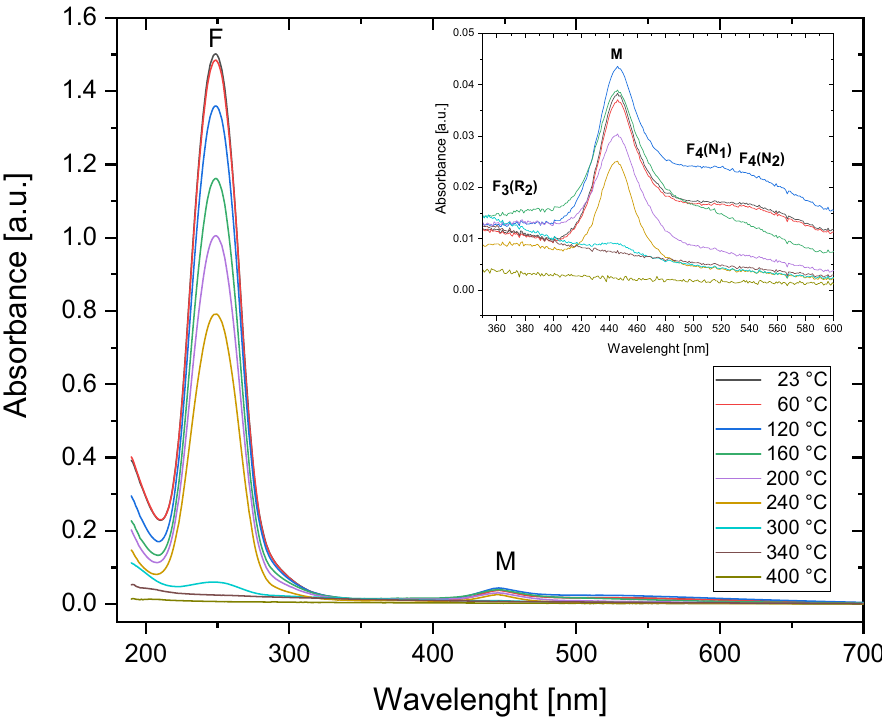
Figure 2. Absorption spectra for the sample irradiated with 30 kGy of beta radiation (Sr ‐ 90/Y ‐ 90) and submitted to a series of subsequent heat treatments at increasing temperatures (Method 1). Measurements were taken at room temperature.